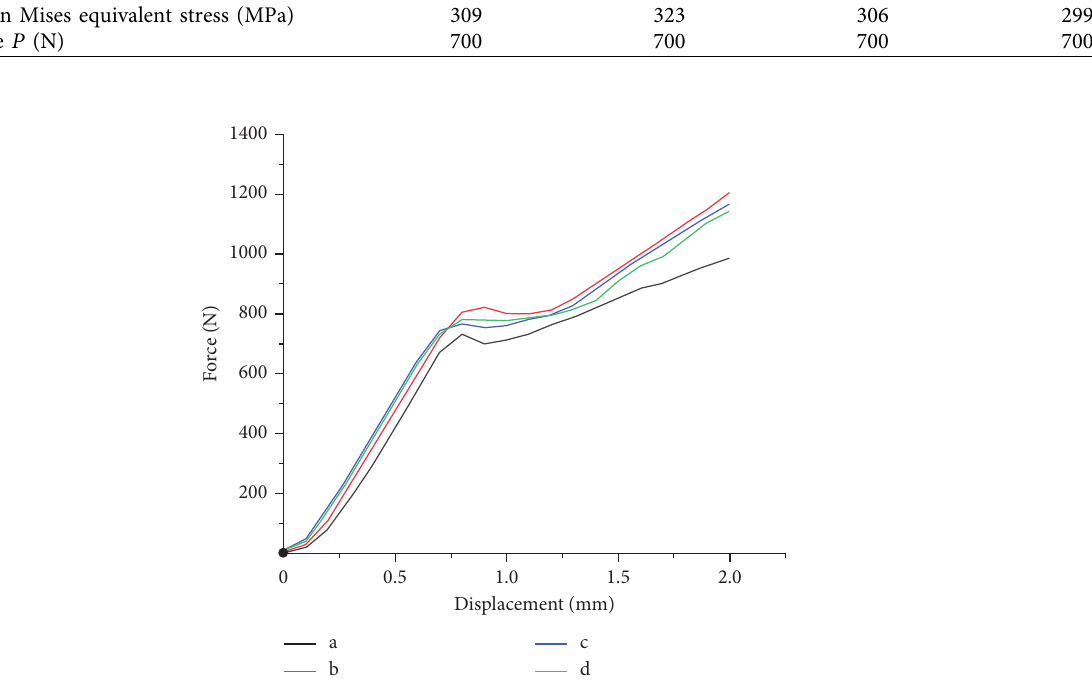
Figure 12: Results of bend test. (a) Case A. (b) Case B. (c) Case C. (d) Case D. Table 13: Results of mechanical bend